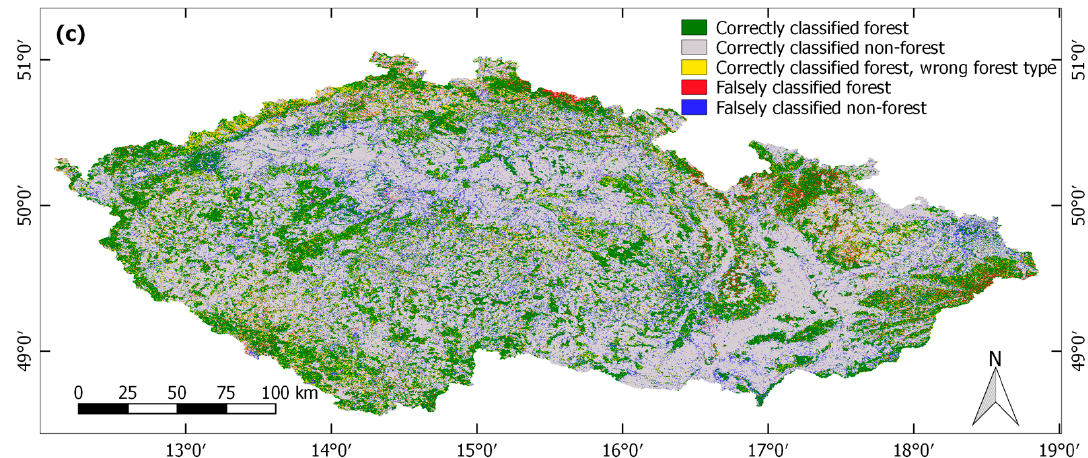
Figure 7. Detailed forest type map of the Czech Republic from ( a ) Sentinel-1, ( b ) Copernicus High Resolution Layers and ( c ) the difference map between the two datasets.